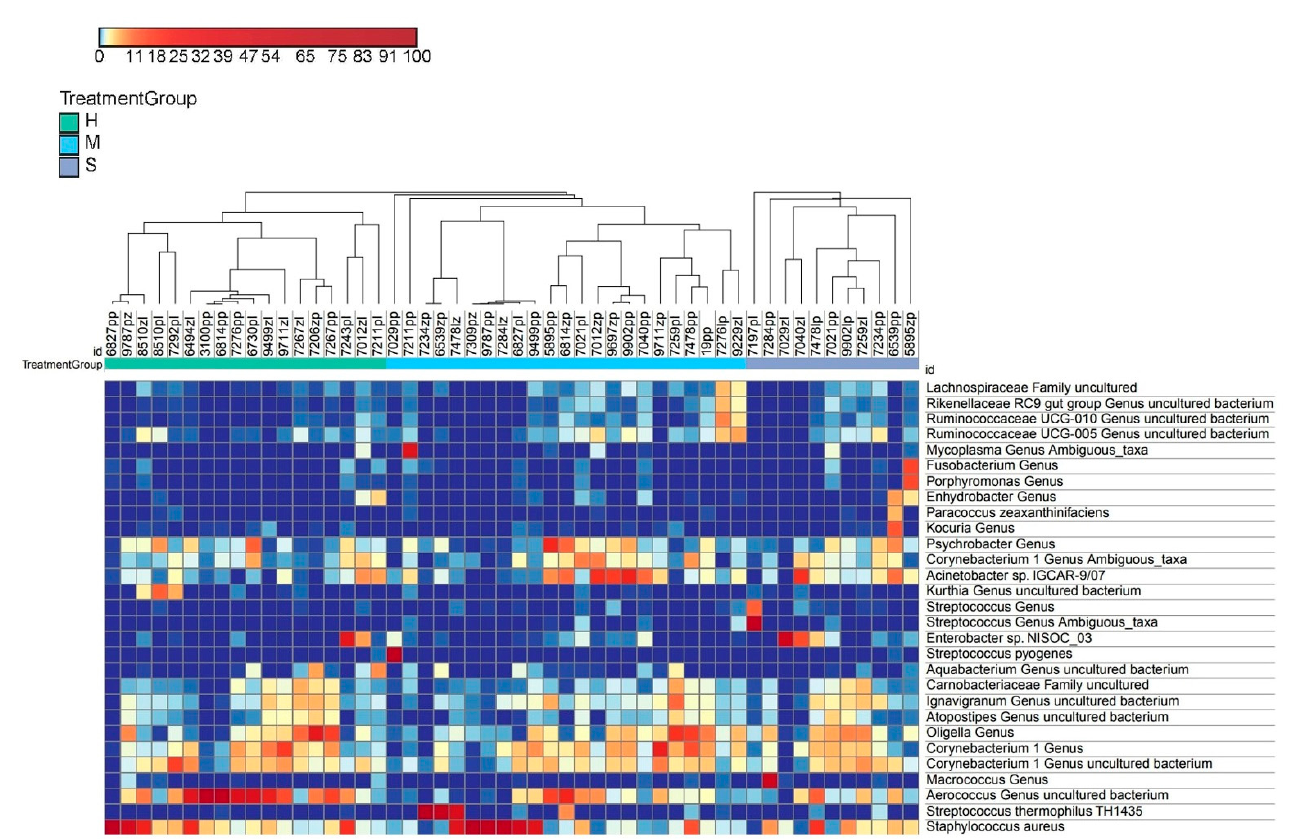
Figure 2. Heatmap of the most abundant OTUs in milk samples. Annotations at the top of the heatmap show clustering of milk samples. The color scale depicts the normalized relative abundance of each OTU. The full OTU heatmap is available as Figure S1. Treatment groups (H, M, and S) are described in Materials and Methods.